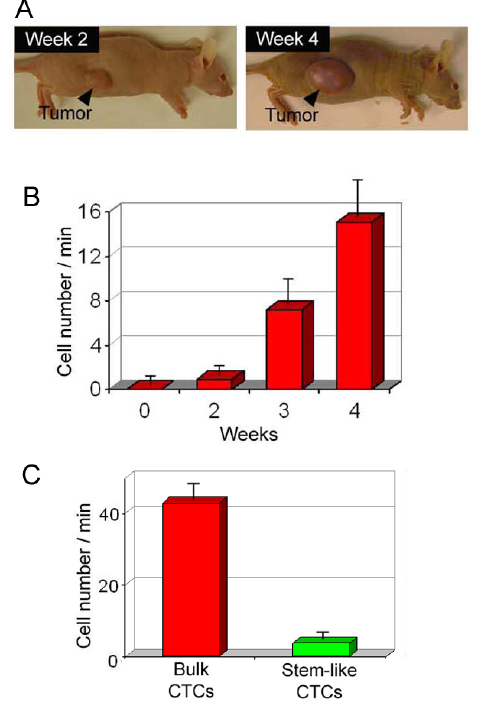
Figure 19. PA detection of bulk and stem-like breast CTCs in tumor-bearing mice. ( A ) The size of the primary breast cancer xenografts at different stages of tumor development; ( B ) Average rate of bulk CTCs in mouse ear vein over a period of several weeks. ( C ) Average rate of CTCs associated with bulk folate + /uPAR + CTCs and folate – CD44 + stem-like CTCs